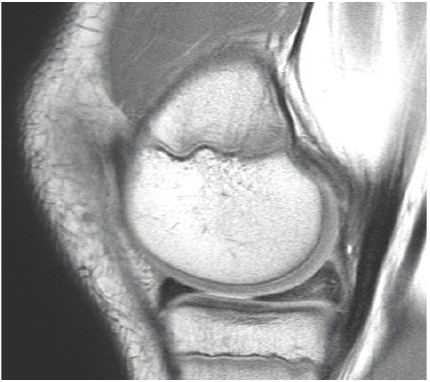
Figure 1: Sagittal MRI of the left medial meniscus with intrasubstance degeneration in the posterior horn.